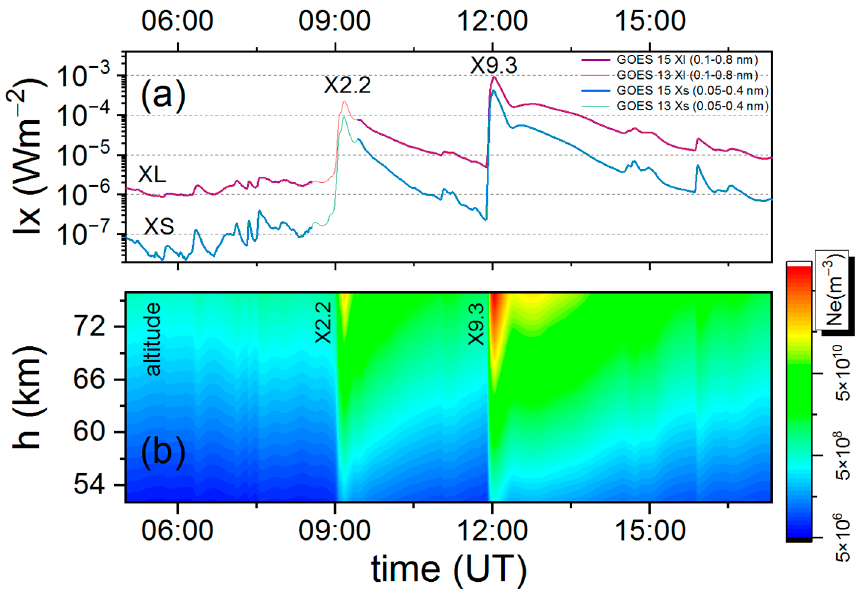
Figure 6. Variation of X-ray flux ( a ) as measured by GOES-15 and -13 satellites and the surface plot of corresponding electron density profile ( b ) versus universal time UT during two successive X-class SFs of 6 September 2017. The results are obtained using simple approximative Equation (3).